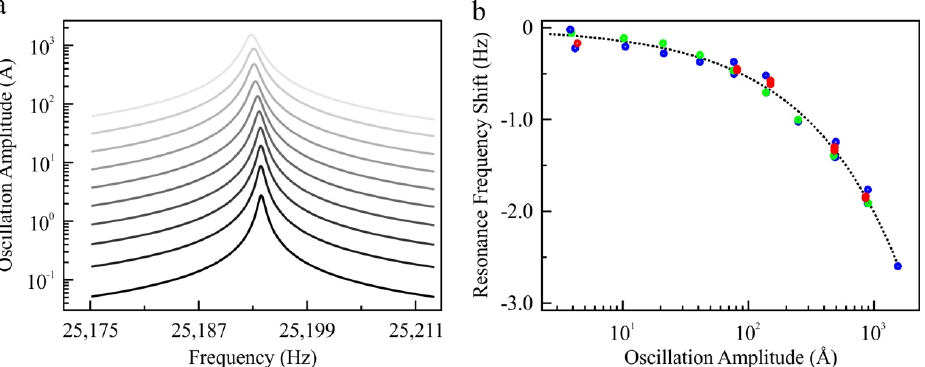
Figure 2. The measurement of the resonance frequency of a tuning fork (type-II, see SM part II for details of the tuning fork used for this specific experiment) in the qPlus configuration. Frequency sweep experiments ( a ) were conducted to determine the resonance frequency. The oscillation amplitude of the qPlus is calibrated with the principle of energy dissipation, which has a picometer range accuracy [30]. The frequency resolution of resonance sweep experiments is 10 milli-Hz for tuning forks in the qPlus configuration (see SM part II for further details of experimental techniques). ( b )We fit a curve to experimental data (black, dashed line, R 2 = 0.99 for the fit), ∆𝑓 = −0.03548 × 𝐴 (cid:2868).(cid:2873)(cid:2876)(cid:2872) , where ∆𝑓 is the resonance frequency shift in Hz and A is the oscillation